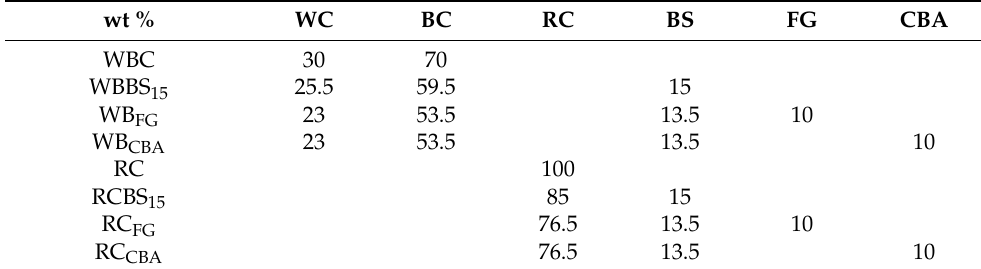
Table 1. The wt % components ratio in the studied